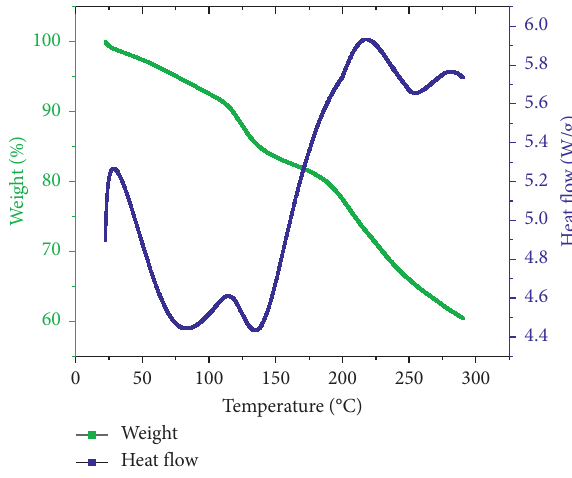
Figure 8: DSC and TGA thermogram of 5a. Table 10: DSC transition temperatures of O-glycopyranosides.